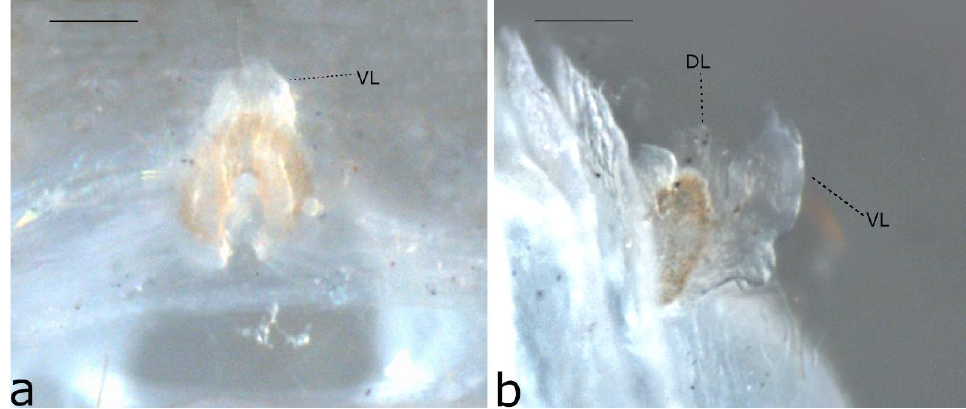
Figure 60. Ariadna tangara Marsh, Baehr, Glatz & Framenau, 2018. ♀ holotype (SAMA NN29864) from Kangaroo Island (SA): anterior receptaculum ( a ) ventral view; ( b ) same, lateral view. Scale bar = 0.2 mm. DL = dorsal lobe, VL = ventral lobe.